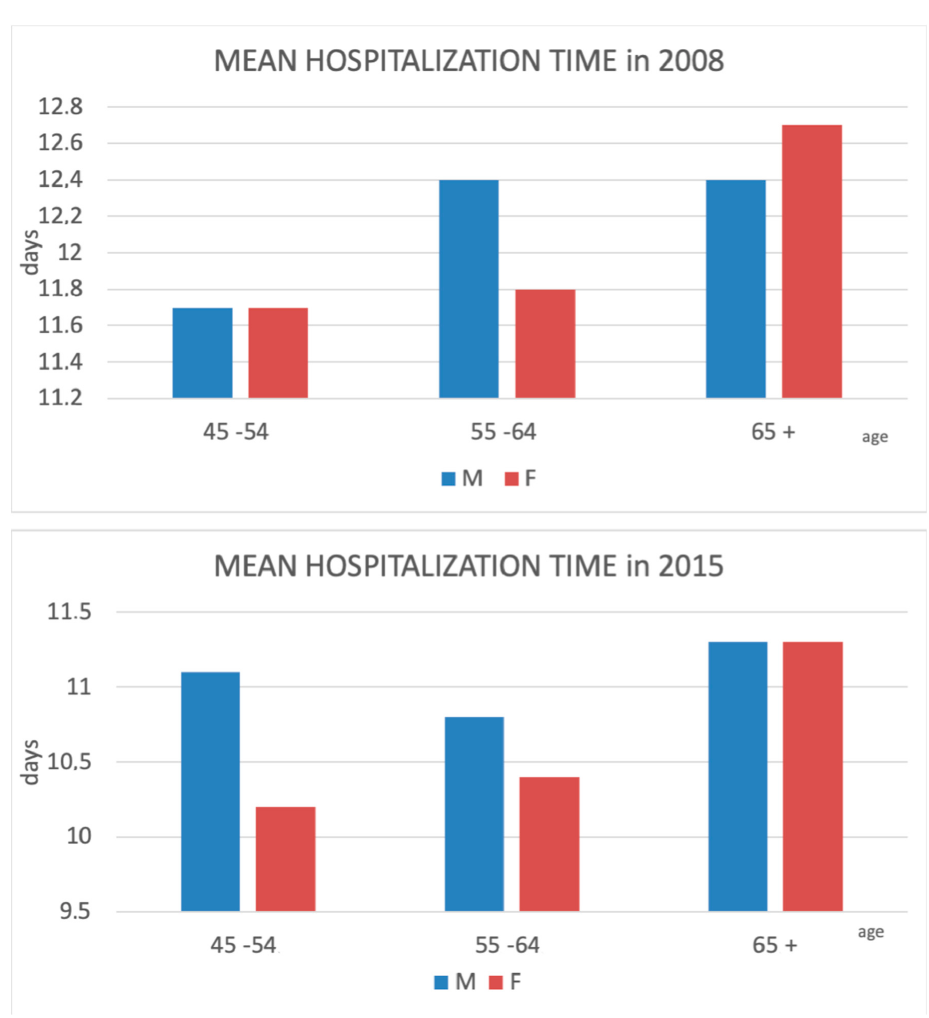
Figure 6. Comparison between hospitalization time due to HF (hip fracture) in different age groups at the beginning and end of the study period.